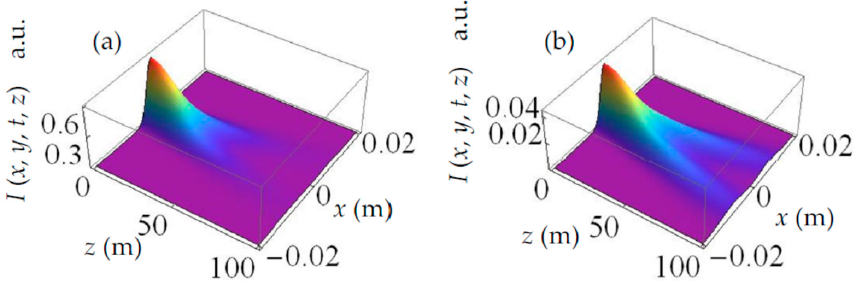
Figure 2. Evolution of spatiotemporal intensity I ( x , y , t , z ) (Equation (20)) of spatial cosine-Gaussian and temporal Laguerre–Gaussian correlated Schell-model (SCTLGSM) pulsed beam as a function of propagation distance z and horizontal coordinate x with different time ( a ) t = 2 ps and ( b ) t = 5 ps, and for m = 1, s =